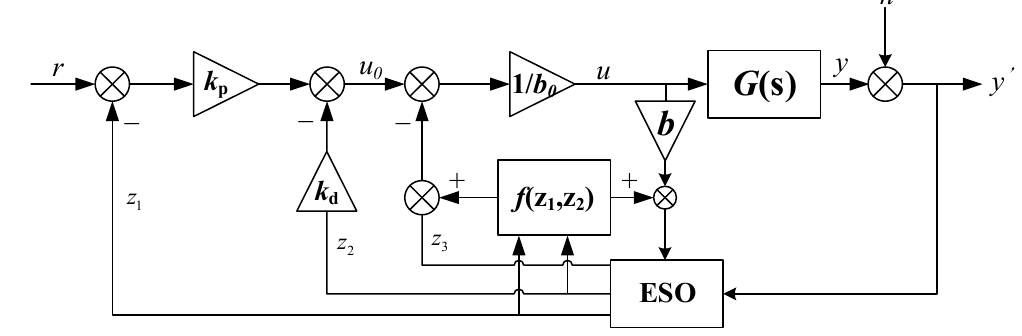
Figure 4. The MADRC block diagram with measurement noise.